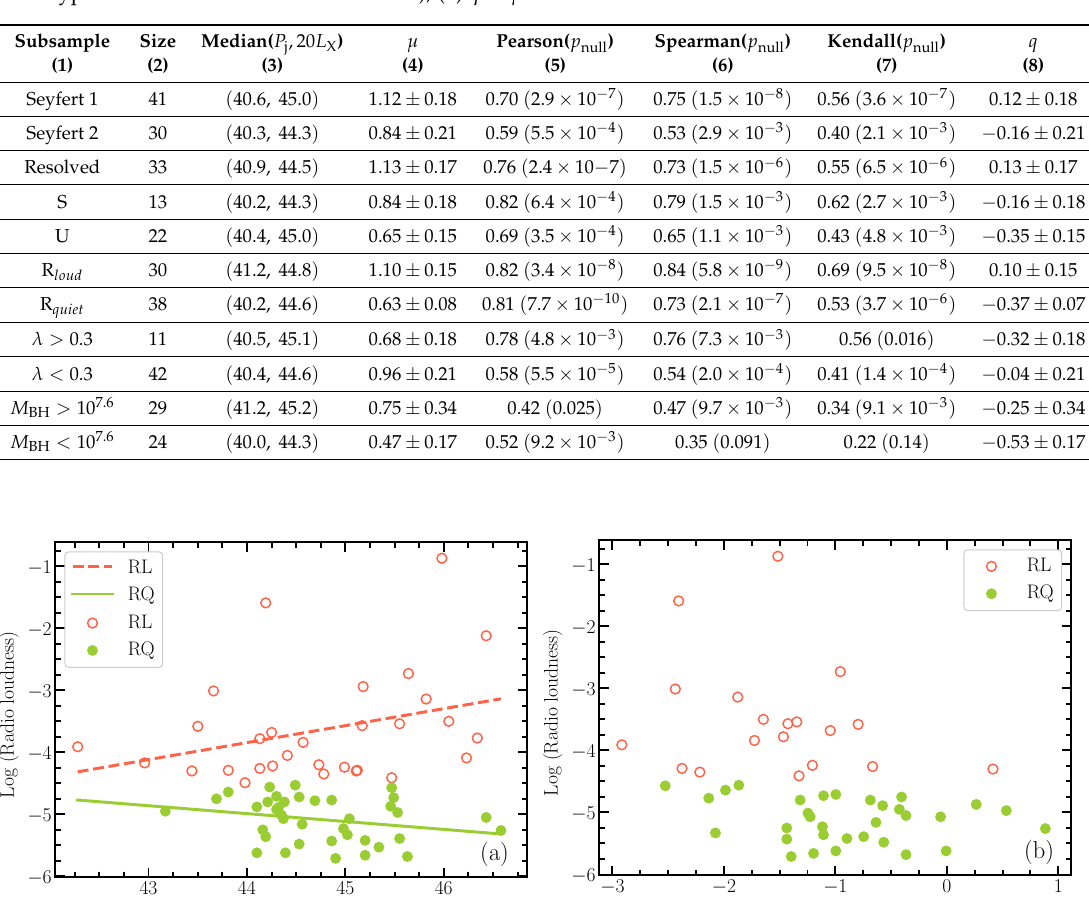
Table 1. The results of linear regression fits and correlation coefficients for Log P j = µ Log(20 L X )+b, the columns are (1) subsample (Seyfert 1s, Seyfert 2s, resolved source by VLA, S: slightly resolved by VLA,